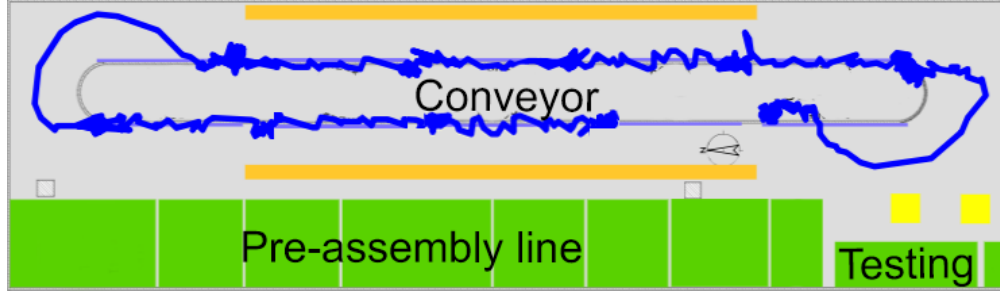
Figure 5. Illustration of how the internal positioning system (IPS) tracks a product in the conveyor at the table. The tracking is accurate and nicely depicts the rotations of the table at the edges of the